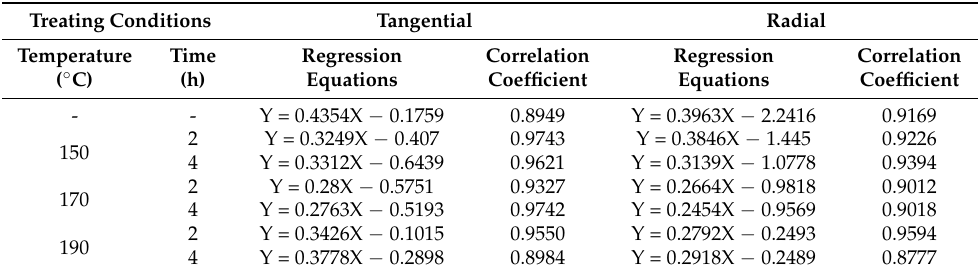
Table 1. Regression Equations and Correlation Coefficient of Swelling Ratio and Moisture Content of Control and HT Wood.